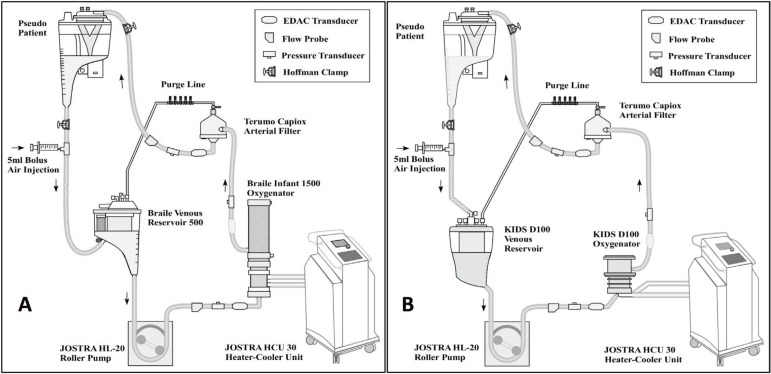
Outline of CPB circuits with the Braile Infant 1500 oxygenator (A)
and KIDS D100 oxygenator (B). (In the experimental set-up, the
venous reservoir was placed directly on top of the oxygenator. They
are separated in this schematic in order to display all components
of the circuit clearly).